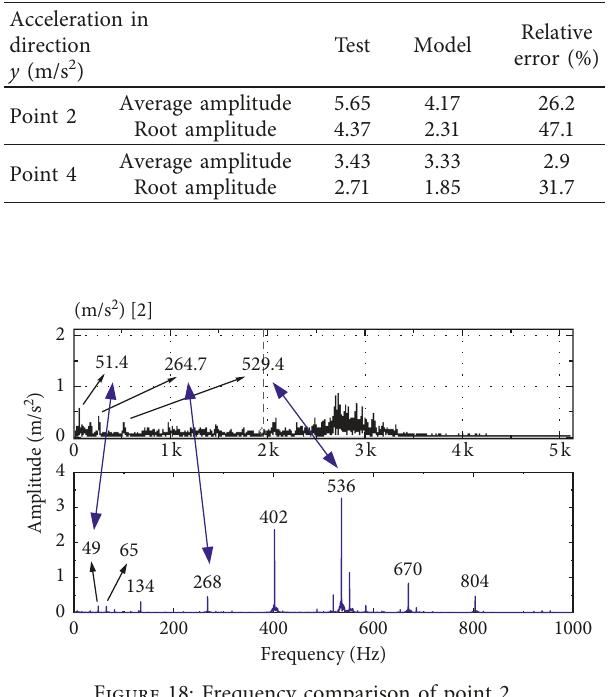
Figure 18: Frequency comparison of point